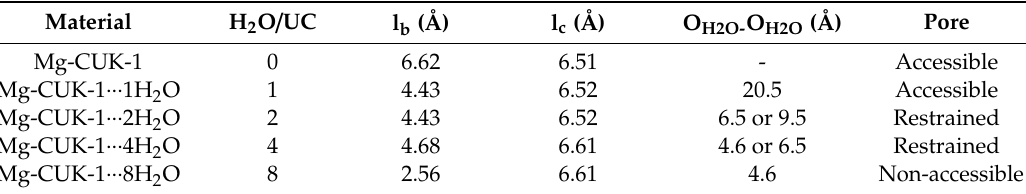
Table 1. Mg-CUK-1 one-dimensional channel dimensions at di ff erent H 2 O molecule loadings. The window dimensions l b and l c (Å) were estimated using a 0.002 au isosurface with CrystalExplorer [14,15].